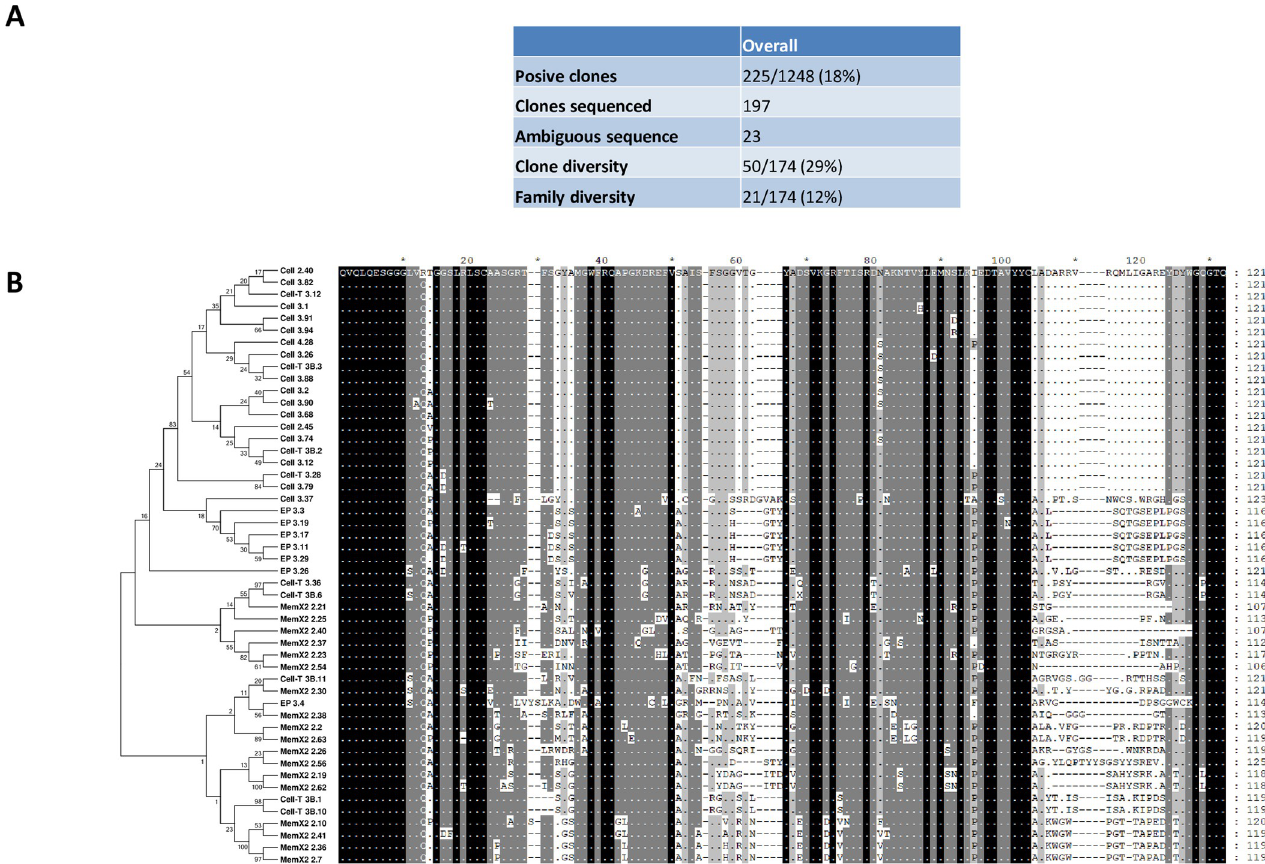
Fig 1. (A) Overview of the overall panning results obtained using 5 different approaches with numbers of positive clones and the resulting clone and family diversity. (B) Alignment of the different identified Nb clones with a corresponding maximum likelihood